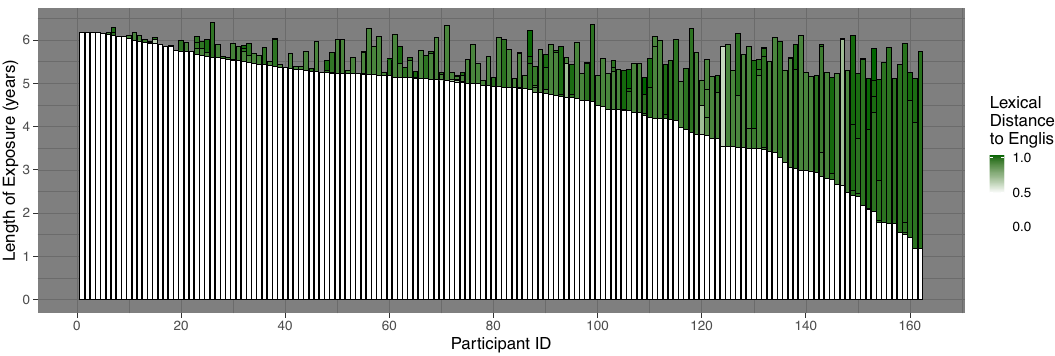
Figure 1. Illustration of the sample’s language background. Each bar represents a single participant; the height of the whole bar represents their age; the height of the white part—their cumulative length of Exposure to English; Cumulative length of exposure to other languages is represented by the height of the green part within each bar; the shade of the green stands for the lexical distance of each language to English (indexed by LDND), the darker the shade, the more lexically distant from English the language. Prior to plotting, data was sorted by the Cumulative Length of Exposure to English values; consequently, data of children exposed to English the longest can be found on the left-hand side of the figure, the right-hand side includes data from participants with the least exposure to